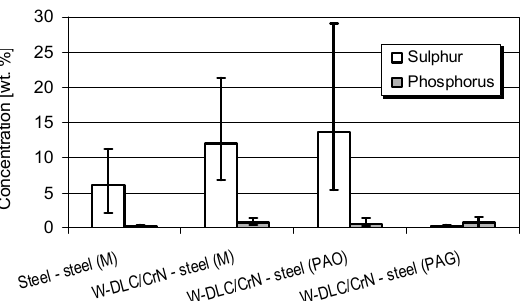
Figure 16. Quantitative results of the EDS analysis of sulfur and phosphorus from the worn surfaces of the pins.